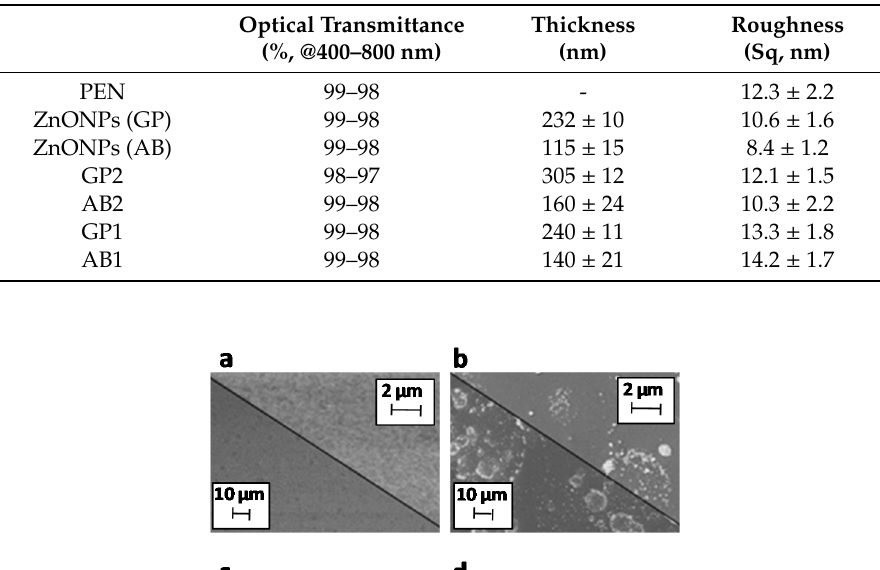
Table 1. Morphological and optical characteristics of the ZnONPs/stearic acid coatings.